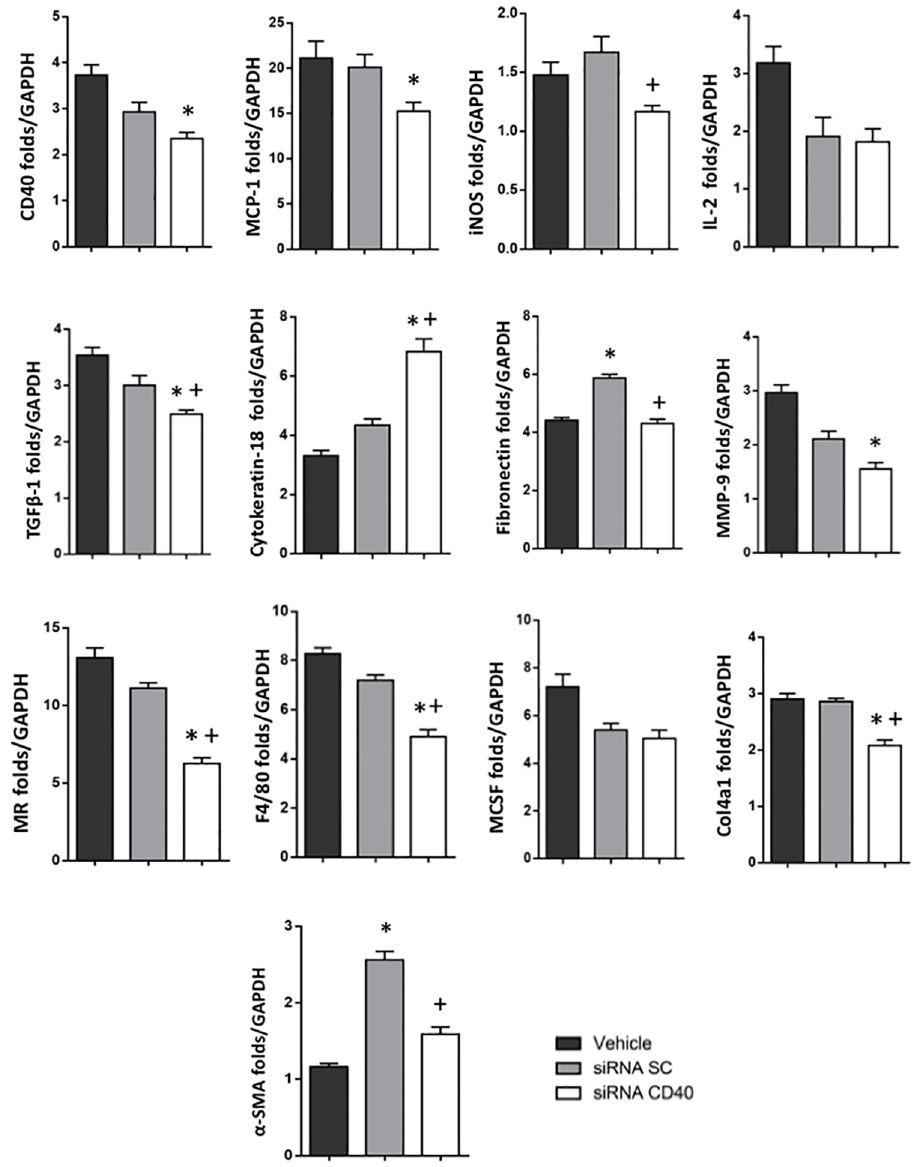
Fig 6. Gene expression profile of the obstructed kidney. For all qRT-PCR analysis, all data are compared to wild type levels. Evaluation of macrophage markers, fibrosis matrix proteins, pro-inflammatory and pro-fibrotic genes after the administration of siRNA-CD40. ANOVA test; values are means ± SE, � p � 0.05 vs D-UUO d2+Vehicle, + p � 0.05 vs D-UUO d2+siRNA SC.